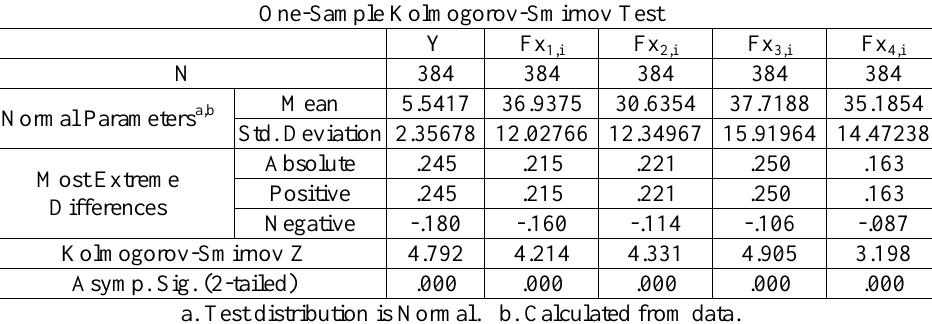
Table. 4. Kolmogorov–Smirnov test to Review Normal Distribution of Data of Research Variables One-Sample Kolmogorov-Smirnov Test Y Fx Fx Fx Fx 1,i 2,i 3,i 4,i N 384 384 384 384 384 Mean 5.5417 36.9375 30.6354 37.7188 35.1854 Normal Parameters a,b Std. Deviation 2.35678 12.02766 12.34967 15.91964 14.47238 Absolute .245 .215 .221 .250 .163 Most Extreme Positive .245 .215 .221 .250 .163 Differences Negative -.180 -.160 -.114 -.106 -.087 Kolmogorov-Smirnov Z 4.792 4.214 4.331 4.905 3.198 Asymp. Sig. (2-tailed) .000 .000 .000 .000